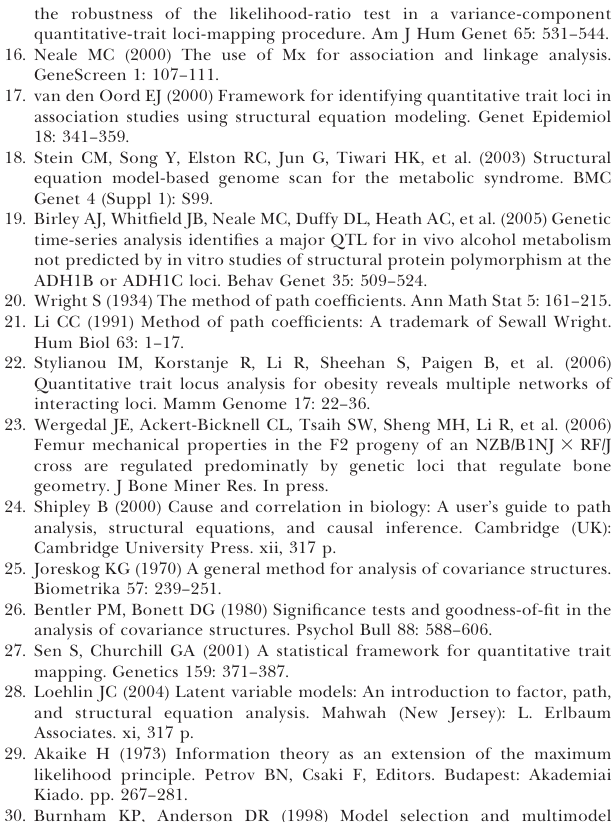
Figure S2. Structural Equation Models for Individual Fat Pad traits